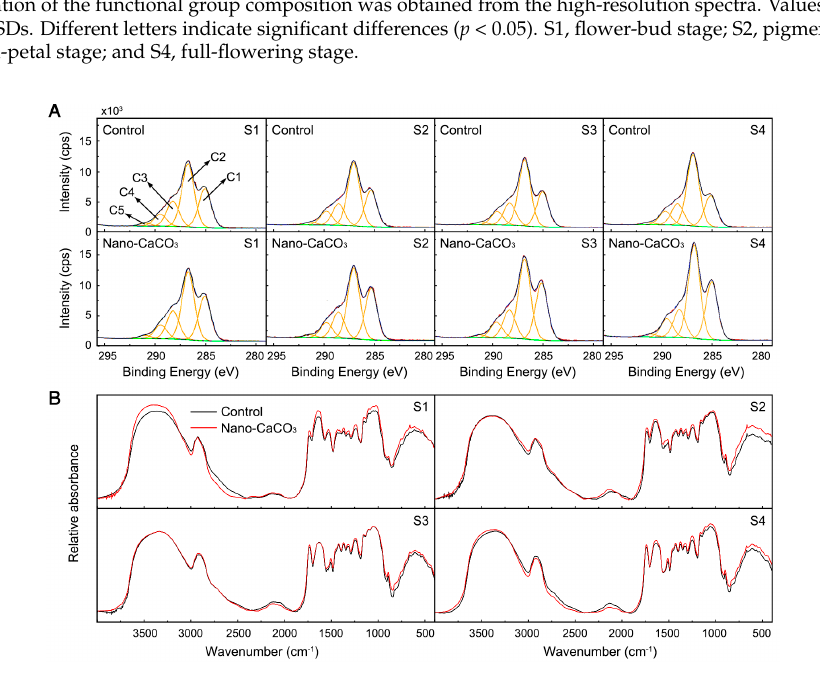
Figure 8. Effects of nano-CaCO 3 treatment on the cell wall compositions of P. lactiflora inflorescence stems. ( A ) Deconvoluted high-resolution XPS C 1s spectrum of cell wall. ( B ) Absorption FTIR spectra of cell wall in the 4000–400 cm − 1 region. S1, flower-bud stage; S2, pigmented stage; S3, unfold-petal stage; and S4, full-flowering stage.